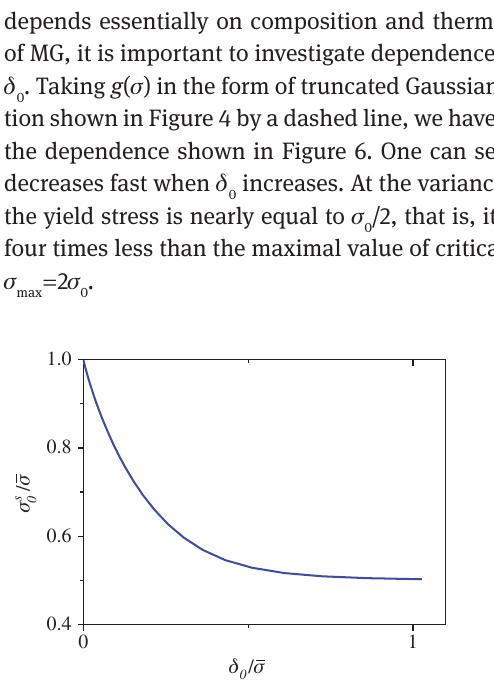
s on the variance of local 0